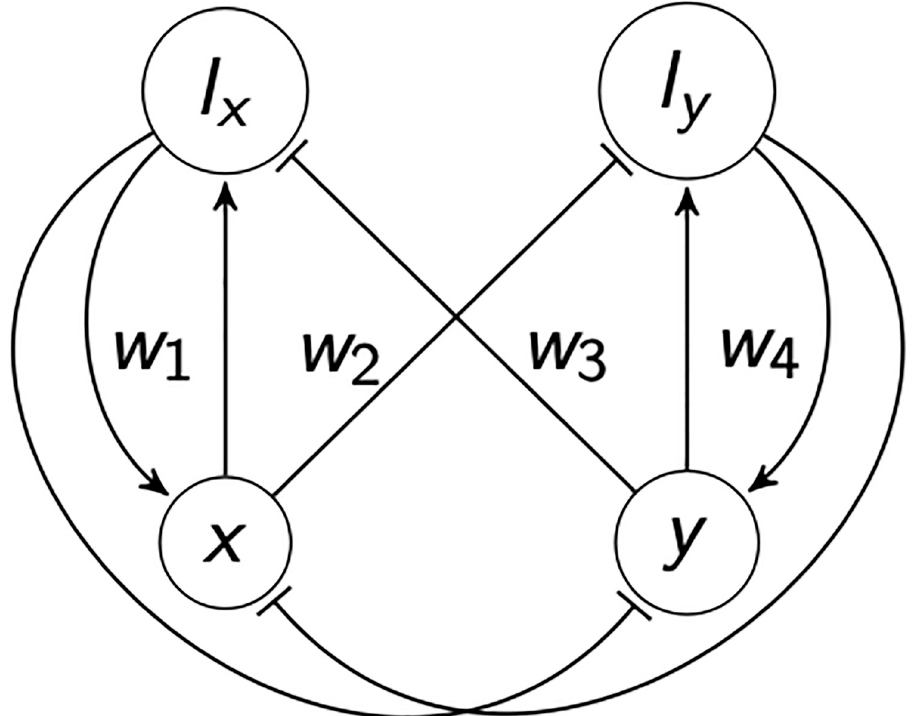
Fig 1. The feed-forward and feed-back structure of populations of agents ( x , y ) competing through learned ( w ) support for two institutions that act as ledgers summing inputs into position values ( I x , I y ) that quantify power or popularity. These values are therefore the sum of a history of popularity and provide feedback by being ‘read’ by populations of agents. Individual agents change in abundance quickly, whereas institutions—as captured in these position values—change slowly through slow learning processes. Standard arrows on edges encode excitation and perpendicular bars on edges encode inhibition. Learning rules operate on the values of w modifying the amplitude of excitation and